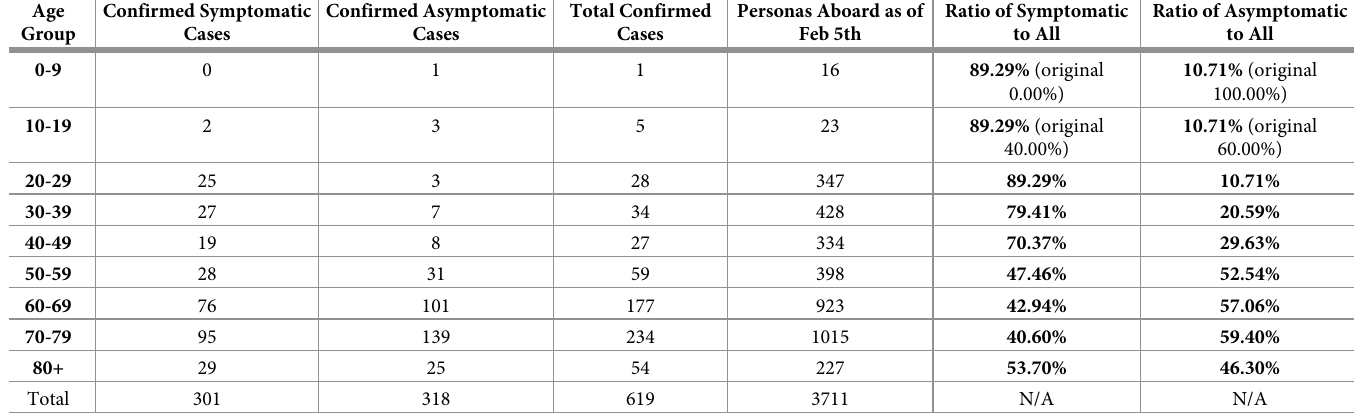
Table 7. Data obtained from Diamond Princess cruise ship [25]. For age-groups 0-9 and 10-19, the total number of infected is too low, hence I have used the values obtained for age-group 20-29 as a